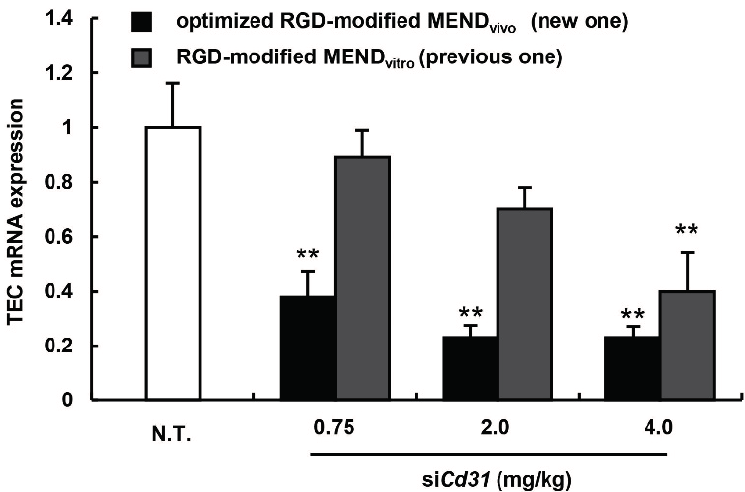
Figure 4. The in vivo silencing efficacy of RGD-modified MEND vivo . The gene silencing in TECs in murine tumor-bearing mice was measured by qRT-PCR 24 h after the injection of 2.0 mg siRNA/kg body weight of MENDs. Black and gray bars denote the optimized MEND vivo and MEND vitro , respectively. Data represent mean ± S.D. ( n = 3) ** , p < 0.01 ANOVA followed by SNK test ( vs . N.T.).